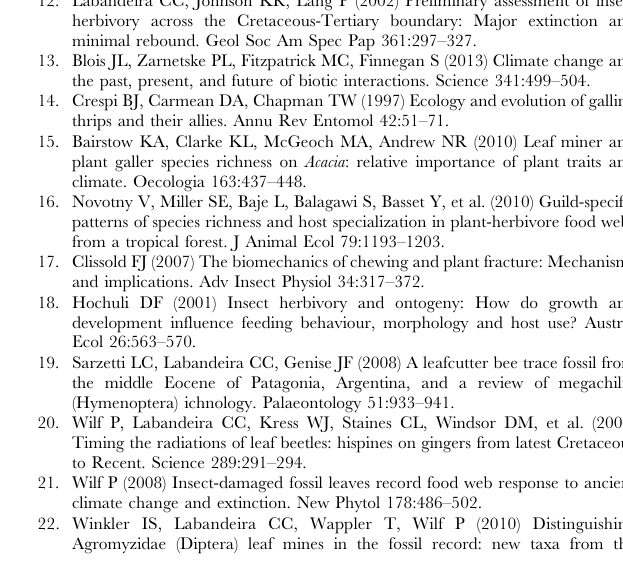
features of each occurrence (grey). Figure S4 Summary of relative frequencies and abun- dances of damage-types (DTs) in living and fossil forests. ( A ) Numbers of insect species at A´ rea Protegida de San Lorenzo and Parque Natural Metropolitano (combined) inflicting each DT. The numbers of insect species are shown as the proportion of total insect species, log-transformed for display. ( B ) Relative abundances of leaf-chewing DTs from 17 fossil floras, estimated from 500 randomly selected fossil leaves and repeated 1000 times (see Materials and Methods, and Table S4), log- transformed for display purposes. Table S1 Numbers of insect species and families, and their induced damage, collected from 24 host plant species in two tropical forests in Panama. Twenty insects were subsampled 100 times from each host plant species to obtain mean subsampled richness. Table S2 External damage types recorded by feeding insects of the A´rea Protegida de San Lorenzo and Parque Natural Metropolitano not described in ref. [4] . See